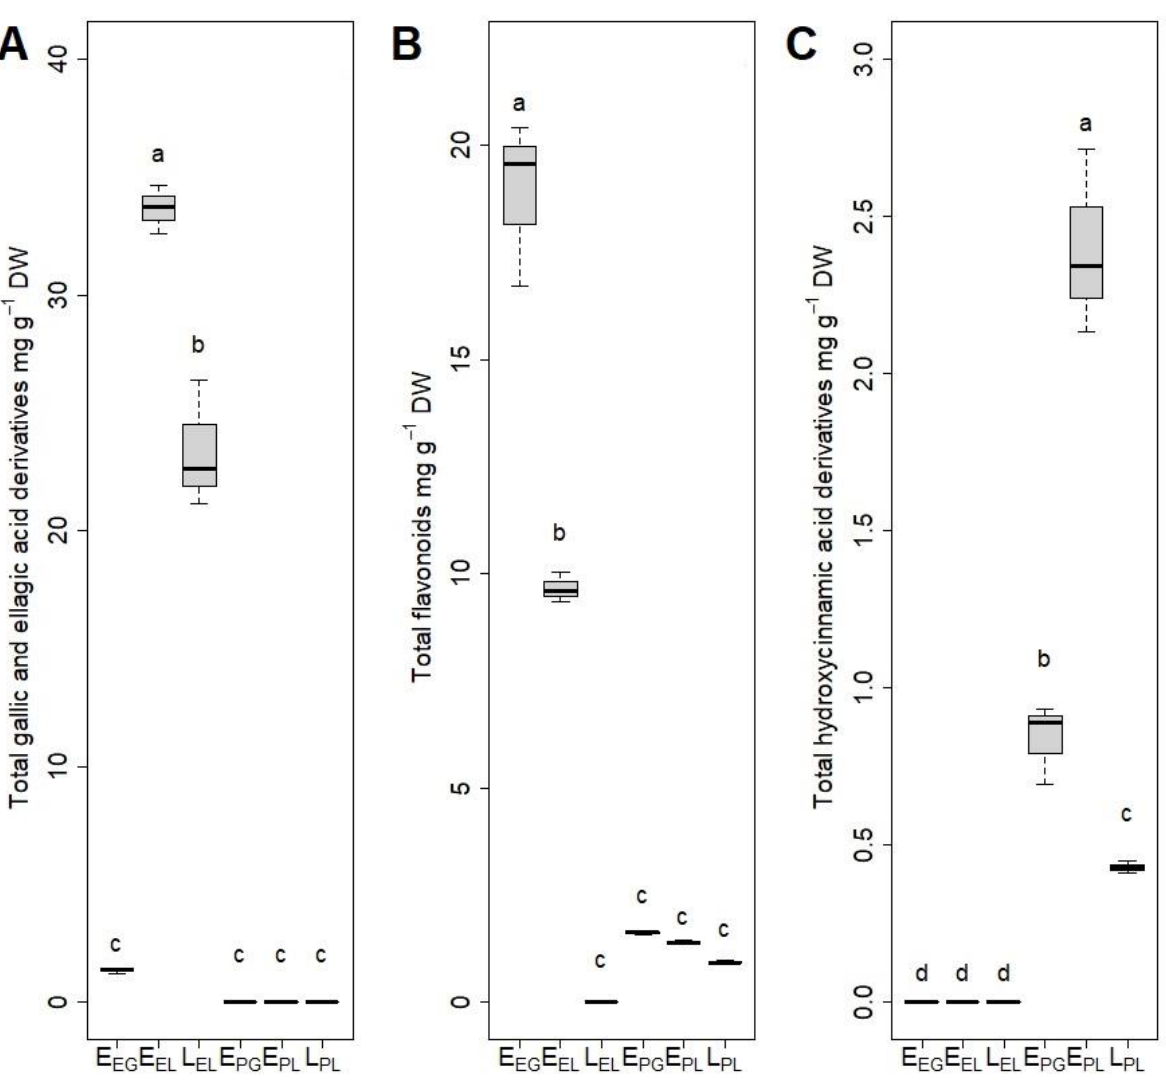
Figure 5. Total content of gallic and ellagic acids derivatives ( A ), Total Flavonoid Content ( B ) and Total Hydroxycinnamic Acid derivatives ( C ) of Eucalyptus and P. undulatum extracts and leachates (mg g − 1 DW) (i.e., E EG = Extract of Eucalyptus spp. Green leaves; E EL = Extract of Eucalyptus spp. Litter; L EL = Leachate of Eucalyptus spp. Litter; E PG = Extract of P. undulatum Green leaves; E PL = Extract of P. undulatum Litter; L PL = Leachate of P. undulatum Litter). Each value is the mean of three measurements ± SD. Bars with the same letter are not significantly different when analysed by a one-way non-parametric analysis of variance (Kruskal–Wallis Test) followed by a Dunn’s Multiple Comparison post-hoc